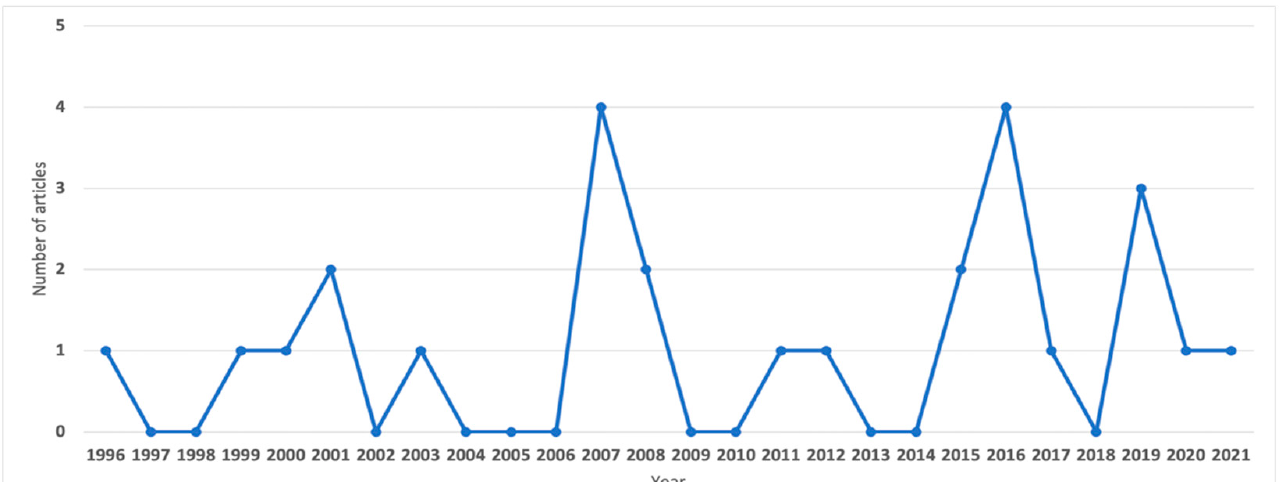
7 of 28 Figure 1. Flow diagram by Prisma 2020. In the data extraction phase, 26 articles (Table A1) were selected for analysis to iden-